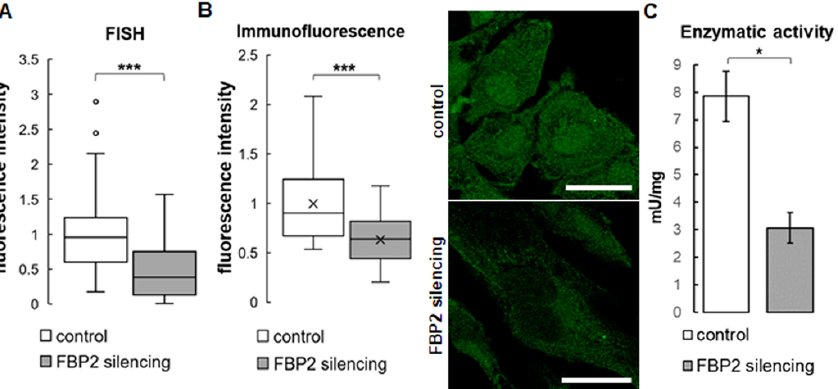
Figure 1. Results of a partial silencing of FBP2 expression in HL-1 cells. Quantification of fluorescence related to FBP2 mRNA level ( A ) and FBP2 protein ( B ), together with representative microscopic images of the protein distribution in the cells, and enzymatic activity measured in homogenates ( C ). Fluorescence was normalized to control group. Data are presented as median and interquartile range ( A , B ) or as mean and standard deviation ( C ). * p = 0.03; *** p < 0.001. Bar = 20 µm.